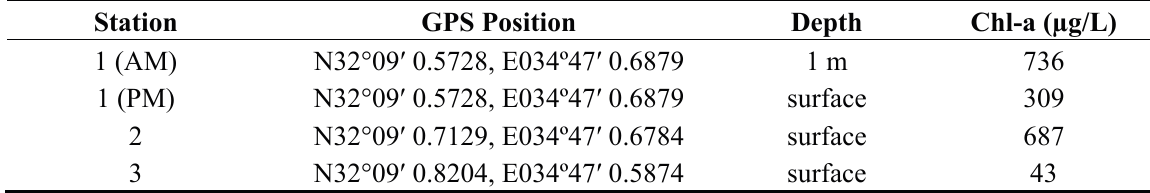
Table 4. Chl-a concentrations measured in the Herzliya